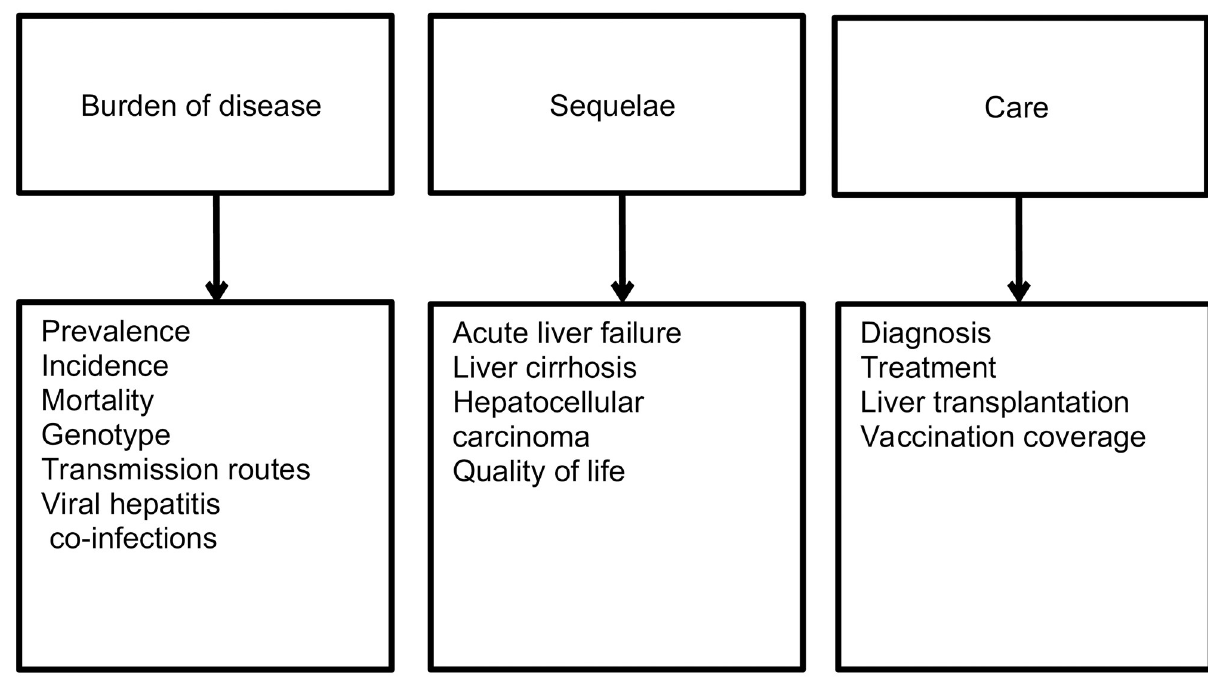
Fig 2. Outcome categories and sub-categories for the